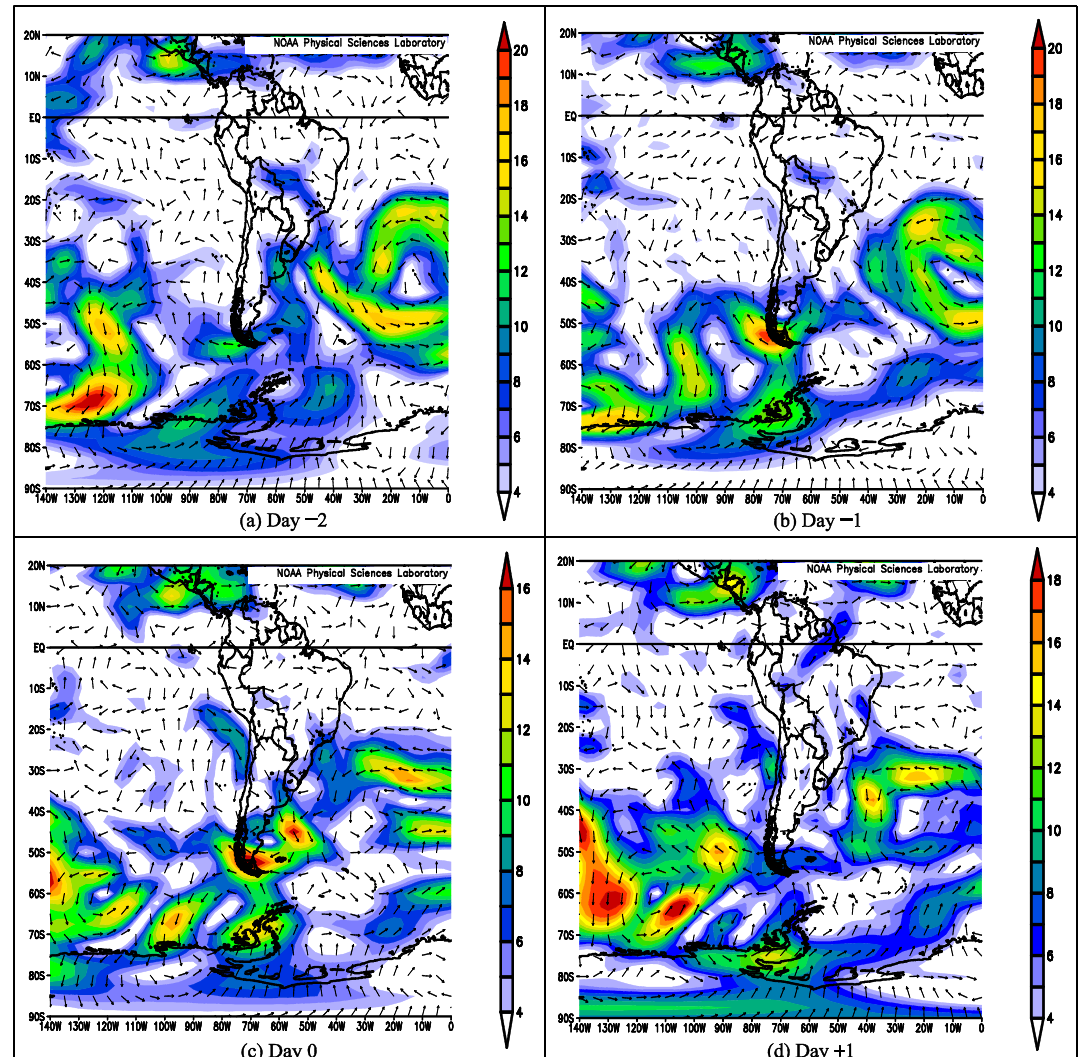
Figure 14. Wind composite anomaly (m/s) at low levels of the atmosphere (850 hPa) for ( a ) day −2, ( b ) day −1, ( c ) day 0, and ( d ) day +1 of the rainfall event on 15 January 1970. Source: NOAA/ESRL Physical Sciences Laboratory. The climatology base period is 1980 – 2010.